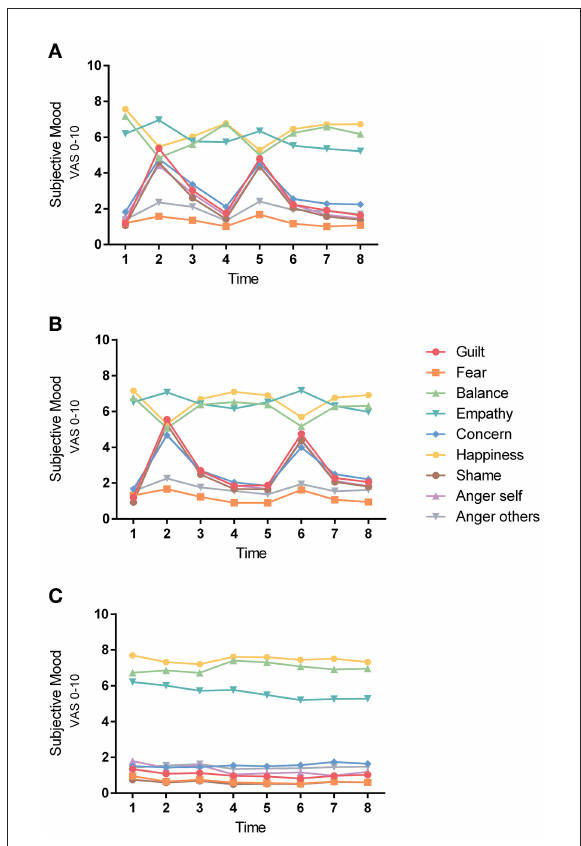
FIGURE2 Course of all emotions. All of the 9 digital VAS emotion ratings for the 3 experimental groups (A) guilt-induction/heat-pain; (B) guilt-induction/cold-pressure-pain; (C) neutral emotion induction/heat-pain are shown. Data of both test-days were collapsed, and means of emotional ratings are shown. Hence, there is no split between